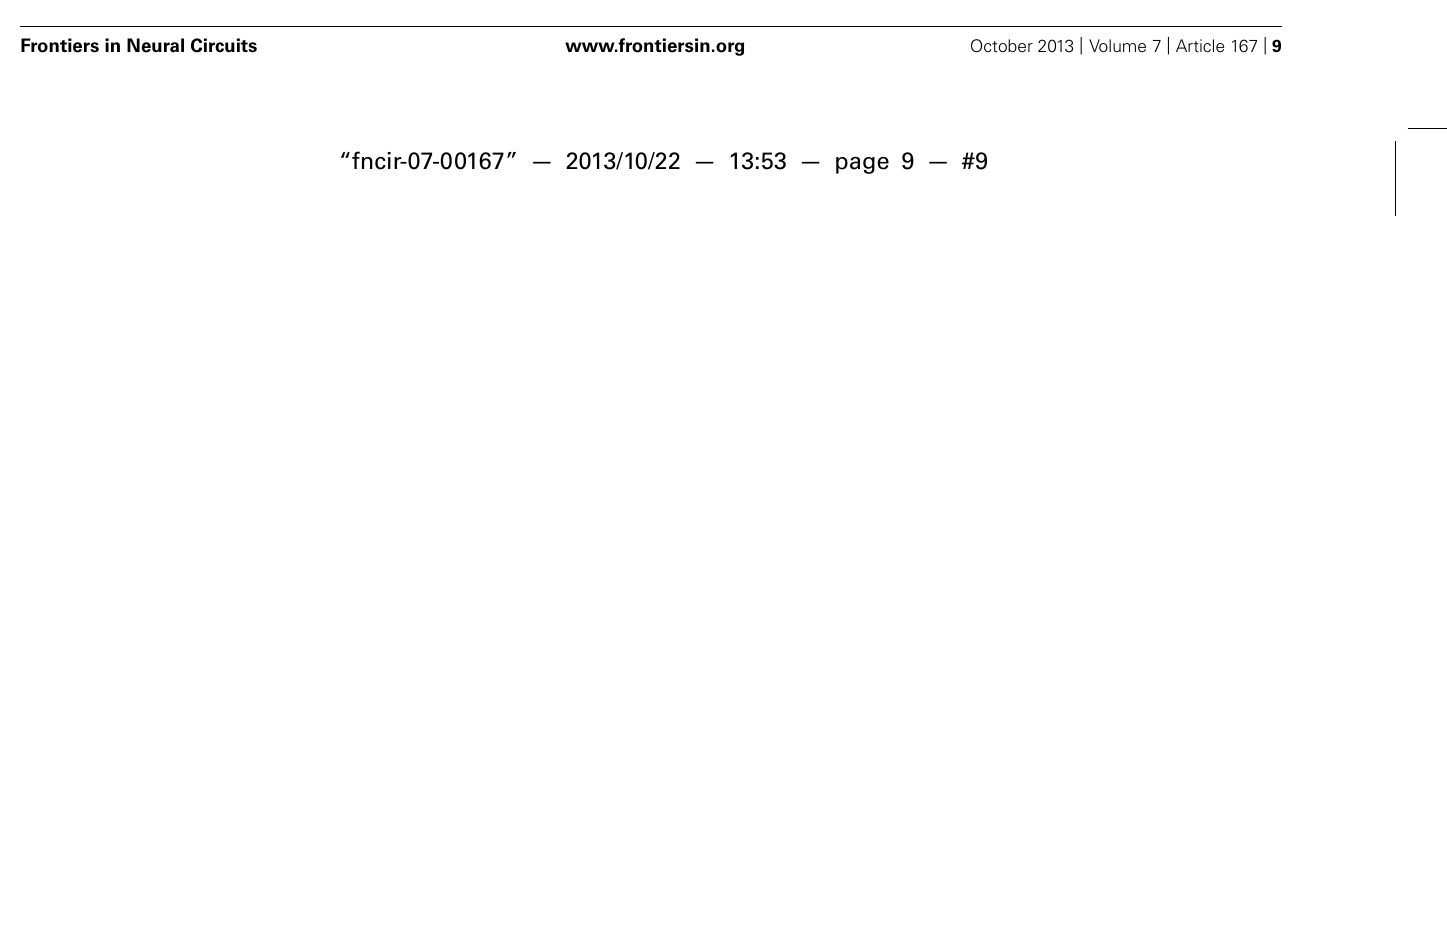
distributions of burst durations before stimulation (blue line) and after stimulation (green line) of pulsed stimulation. (C) Cross correlation functions of fade-in stimulation.The inset represents the average cross-correlation function on a 1 stimescale. (D) Cumulative distribution of the burst duration before stimulation (blue line) and after stimulation (green line) of fade-in